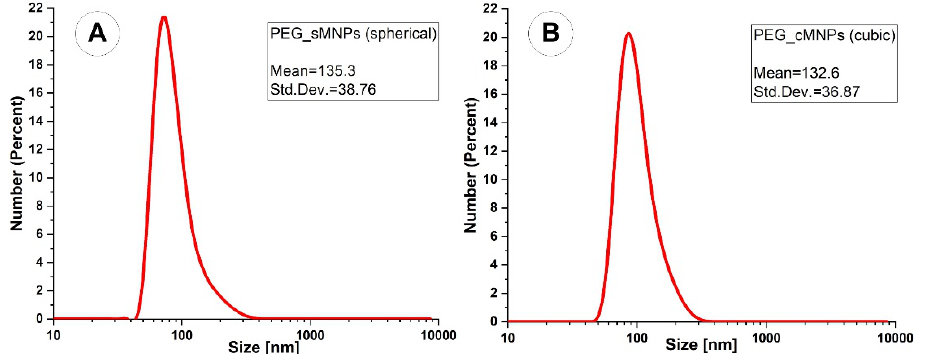
Figure 7. The hydrodynamic diameters of the spherical PEG-coated MNPs ( A ) and cubic MNPs ( B ) were obtained from DLS measurement in the figure: PEG-sMNPs—PEG-coated spherical MNPs, and PEG-cMNPs—PEG-coated cubic MNPs. Table 3. DLS measurements of the PEG-coated MNPs.